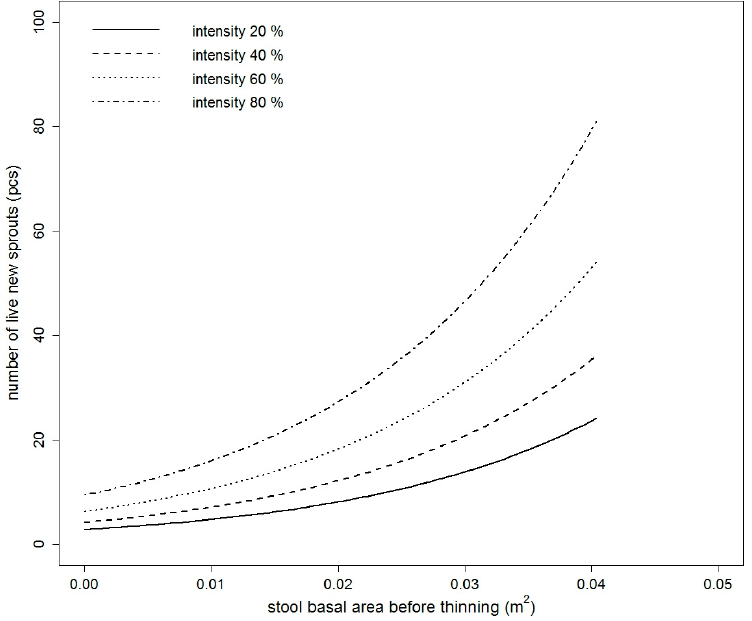
Figure 1. Fitted values of the number of live new sessile oak sprouts model based on the stool basal area before thinning and thinning intensity (2016).